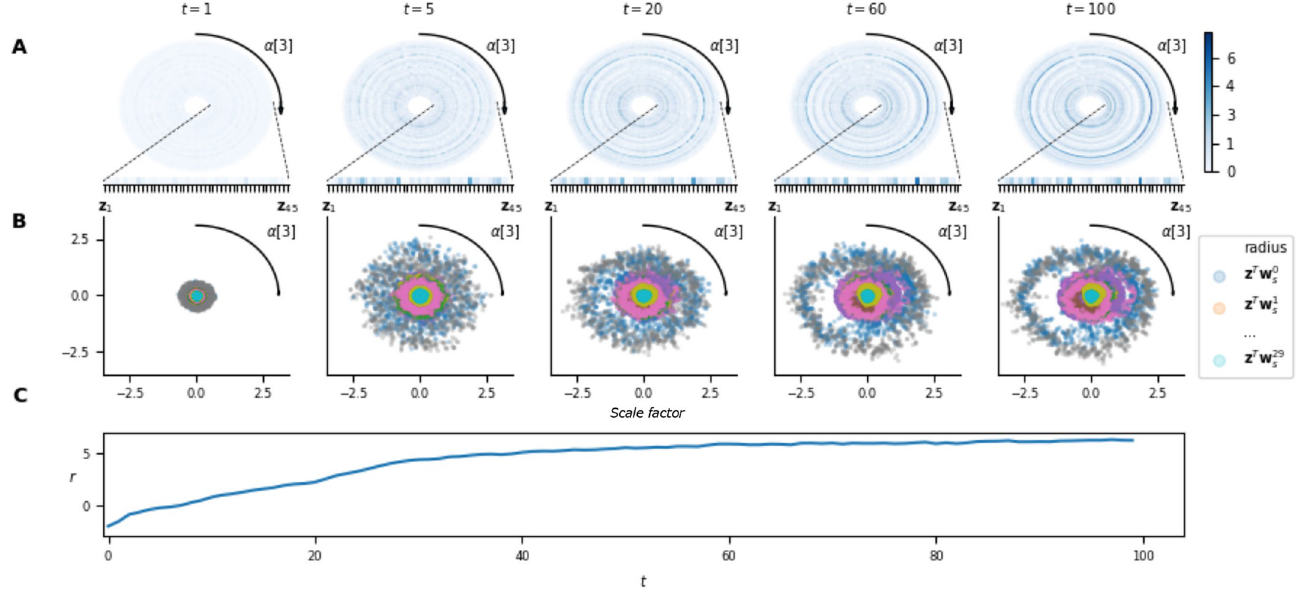
Fig 8. Adaptation capabilities of the NMN architecture on benchmark 2. A . Temporal evolution of the neuromodulatory signal z with respect to α [3], gathered on 1000 different episodes. As α [3] is an angle, the plot is projected in polar coordinates for a better interpretability of the results. Each dimension of z is corresponds to a different radius. B . The value of the scale factors with respect to α [3] for each neuron of a hidden layer in the main network. Again, the plot is projected in polar coordinates. For a given α [3], the values of the neurons’ scale factor are given thanks to the radius. c . Average reward obtained at each time-step by the agent during those episodes. Note that after an average of 40 time-steps, the agent is already achieving decent performances even though z has not yet converged.